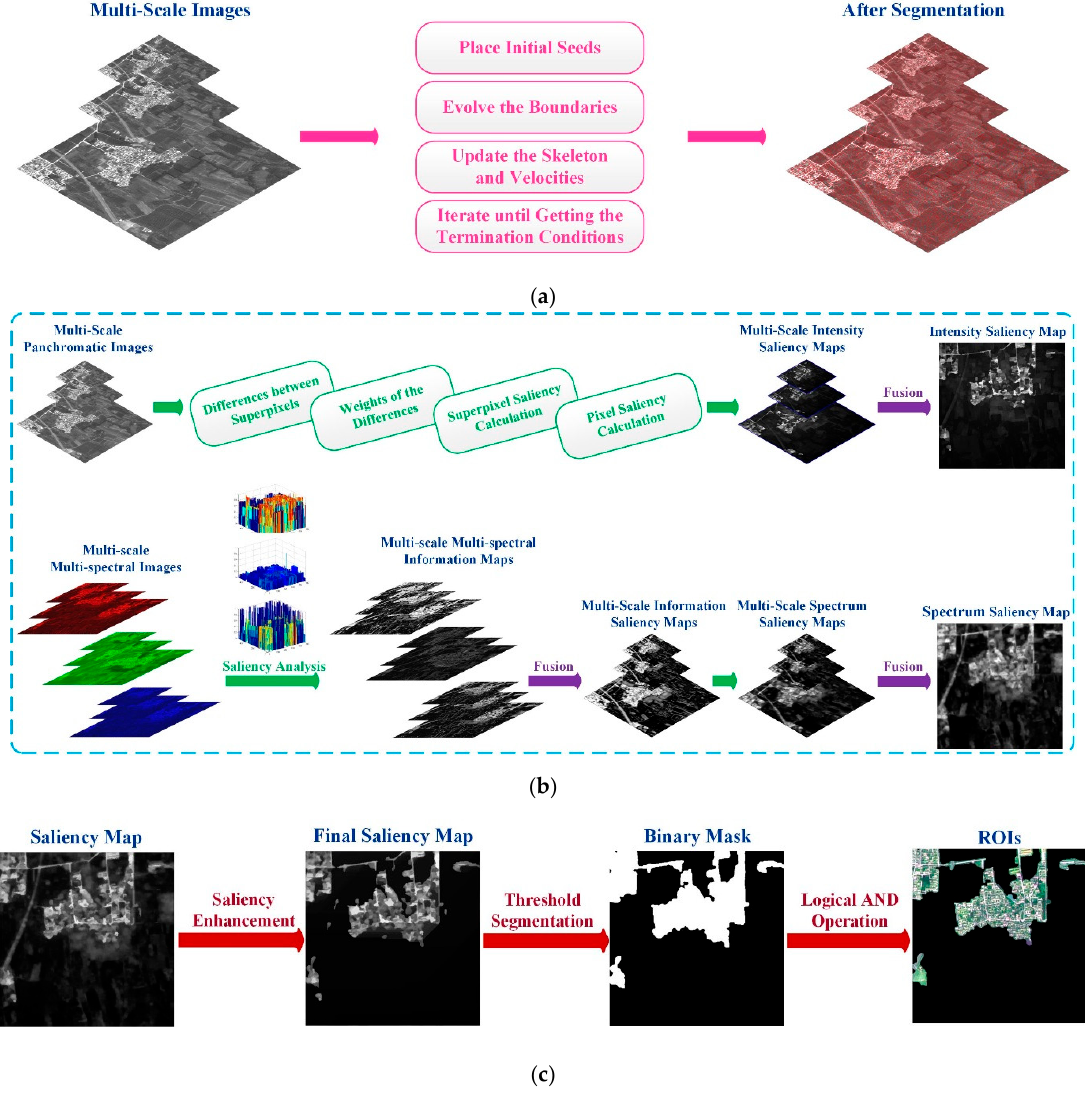
Figure 1. The framework of the LI mode: ( a ) superpixel segmentation; ( b ) saliency analysis; and ( c ) saliency enhancement and region of interest (ROI) extraction.